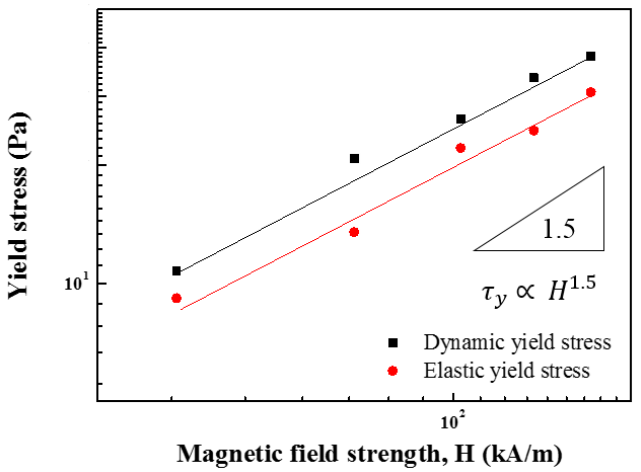
Figure 18. Yield stress as a function of H of ZnFe 2 O 4 /PMA-based MR fluid. The magnetic response of the ZnFe 2 O 4 /PMA particle-based MR fluid was examined by estimating the MR efficiency using Equation